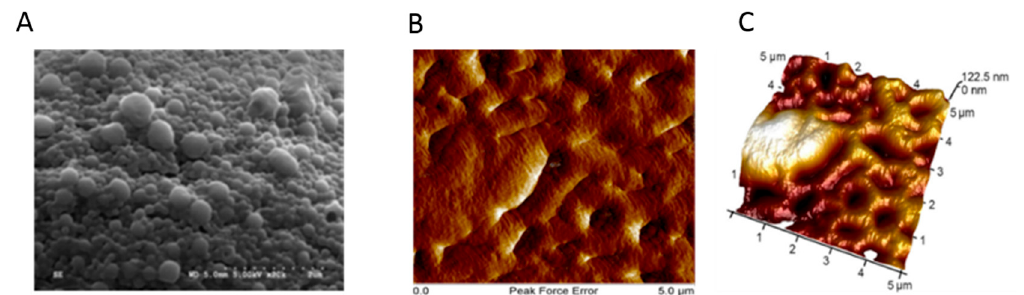
Figure 9. SEM and AFM analysis of the NPs and composite. ( A ) SEM analysis shows spherical morphology of NPs with an average diameter of 186 nm. ( B , C ) AFM result exhibits uniformly distribution of NPs embedded in hydrogel and formed a soft surface. Adapted from [105], Drug Deliv. Transl. Res.